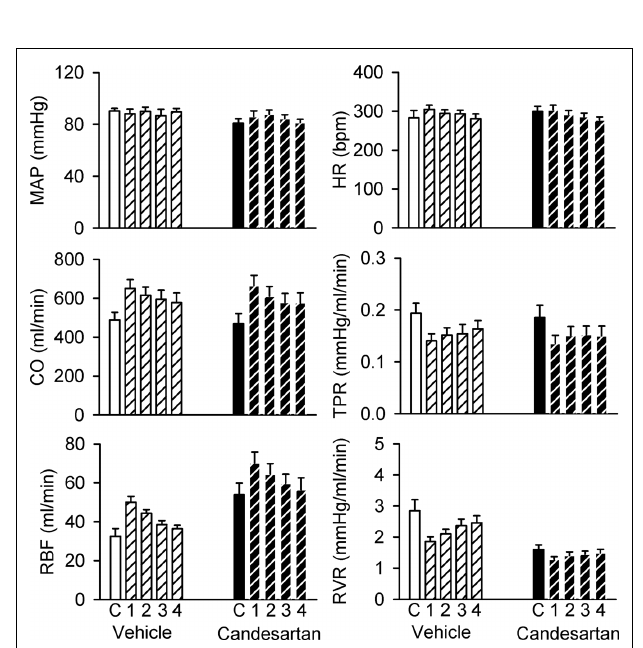
FIGURE 4 | Responses of hematocrit to plasma volume expansion in conscious rabbits treated with candesartan or its vehicle. C = control, 1, 2, 3, and 4 refer to the consecutive 20min clearance periods after plasma volume expansion. P values are the outcomes of two-way repeated measures analysis of variance.These indicate significant effects of candesartan and plasma volume expansion on hematocrit, but no significant effect of candesartan on the response of hematocrit to plasma volume expansion.